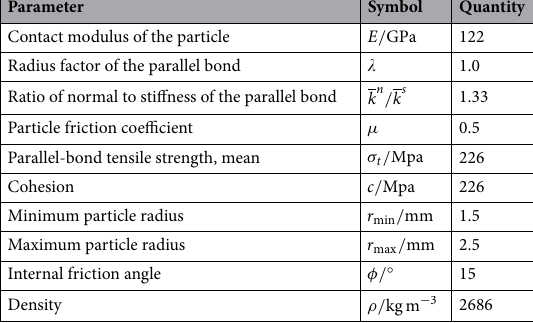
Table 2. Mechanical parameters of the PFC3D